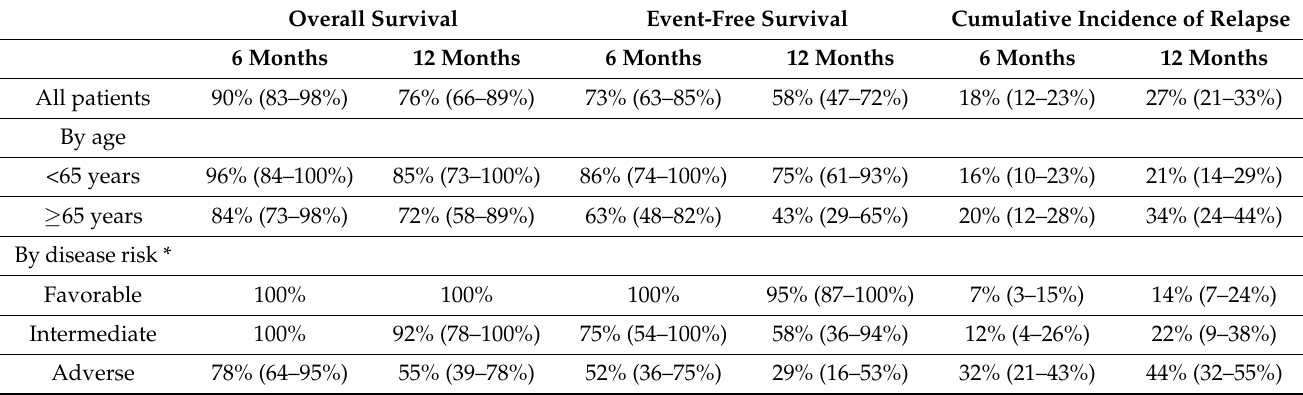
Table 4. Outcome probabilities (with 95% confidence interval) in entire RP2D cohort and stratified by age or cytogenetic/molecular disease risk.